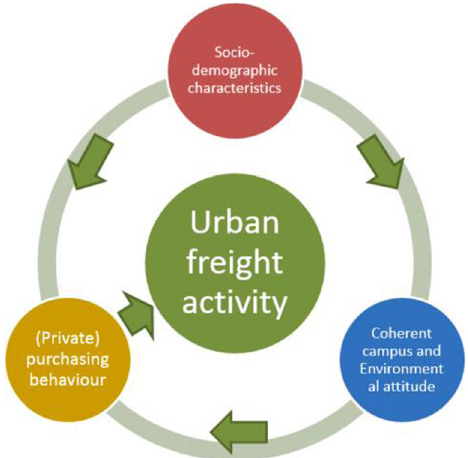
Fig. 1 Illustration of possible key drivers of (private) purchasing behav- iour & impact on urban freight